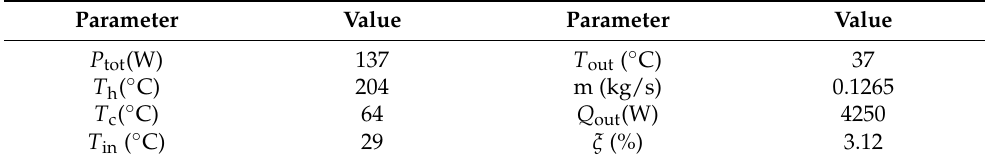
Table 4. Measurements for TE efficiency.